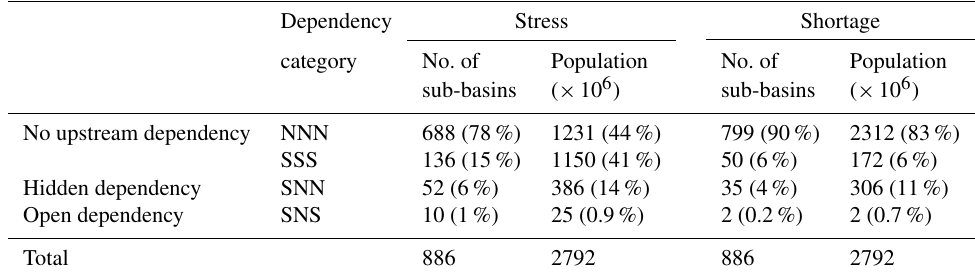
Table 3. Number of SBAs under different dependency categories in the year 2010. Dependency Stress Shortage No.